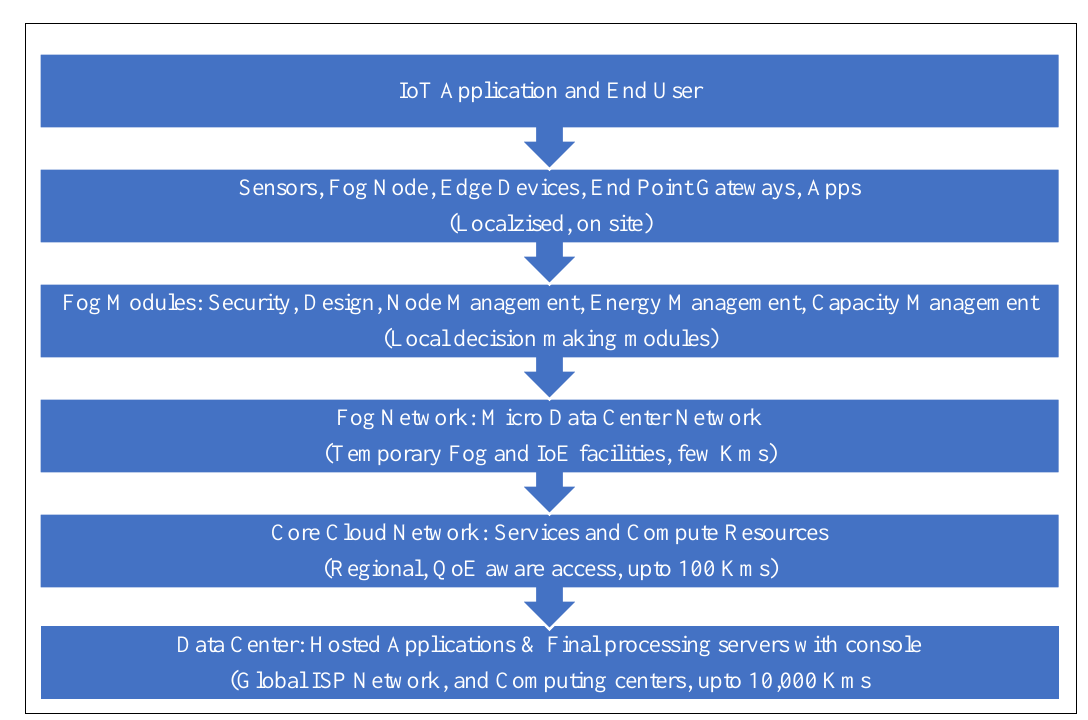
Figure 3. Proposed Reference Architecture for Smart Fog